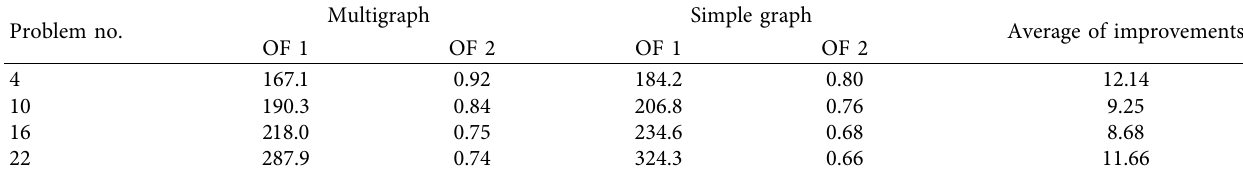
Table 6: The best achieved values of each objective in multigraph network versus simple graph. Problem